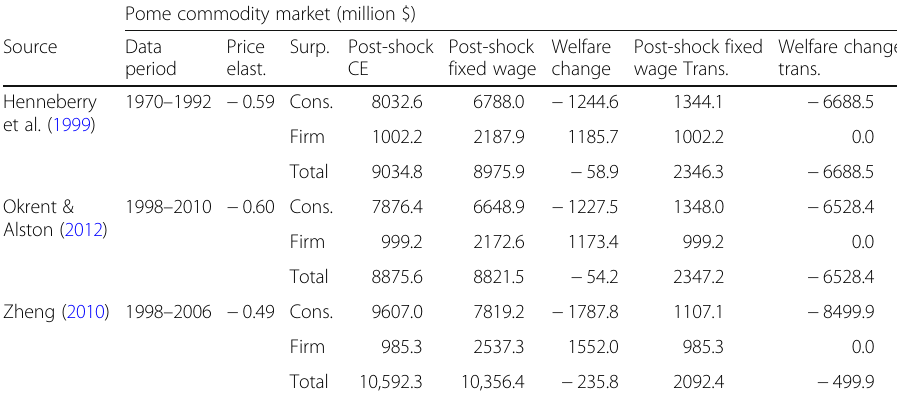
Table 12 Price elasticity of demand welfare impact robustness